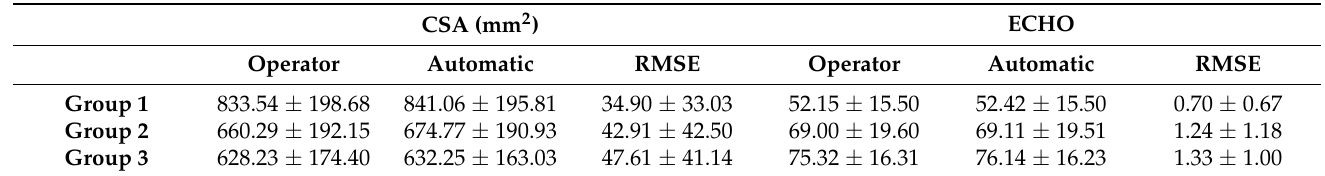
Table 5. A comparison between the manual and automatic CSA/ECHO measurements per group.